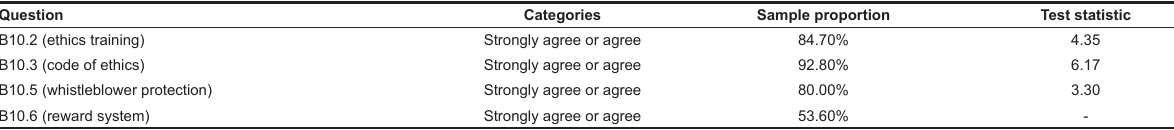
TABLE 8 Characteristics of an ethical